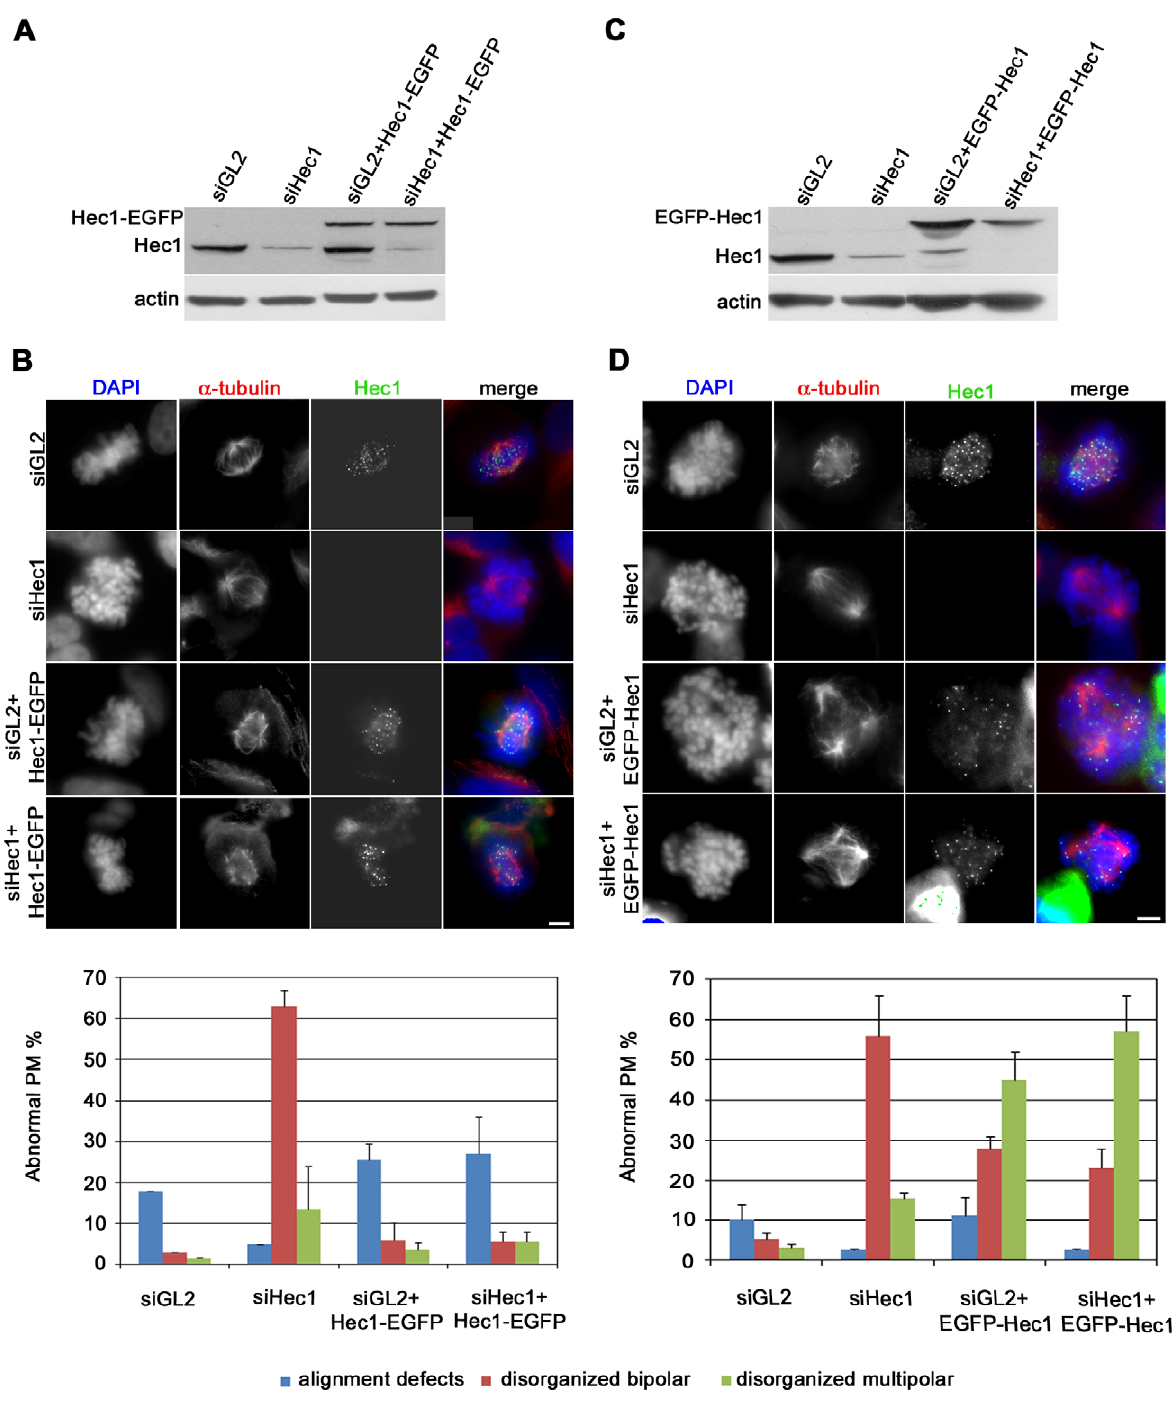
Figure 2. Expression of EGFP-Hec1 does not rescue the mitotic phenotypes induced by Hec1 depletion. (A) Western blot analysis of Hec1 depletion with or without induced Hec1-EGFP expression. (B) Chromosome congression and spindle organization after a -tubulin (red) and DAPI staining (blue) in control (siGL2) or Hec1 silenced (siHec1) mitoses or mitoses expressing Hec1-EGFP after control silencing (siGL2 + Hec1-EGFP) or after Hec1 silencing (siHec1 + Hec1-EGFP). In siGL2 and siHec1 samples, Hec1 is visualized by antibody staining. The graph reports the frequencies of prometaphase abnormalities in the different conditions in Hec1-EGFP cells. Data are mean 6 SE of 200 PM scored for each condition in two independent experiments. (C) Western blot analysis of Hec1 depletion with or without induced EGFP-Hec1 expression. (D) Chromosome congression and spindle organization after a -tubulin (red) and DAPI staining (blue) in control (GL2) or Hec1 silenced (siHec1) mitoses or mitoses expressing EGFP- Hec1 after control silencing (siGL2 + EGFP-Hec1) or after Hec1 silencing (siHec1 + EGFP-Hec1). In siGL2 and siHec1 samples, Hec1 is visualized by antibody staining. The graph reports the frequencies of prometaphase abnormalities in the different conditions in EGFP-Hec1 cells. Data are mean 6 SE of 200-300 PM for each condition in two-four experiments. Disorganized bipolar prometaphases were significantly induced by siHec1 in both clones (P , 0.01, t-test) and disorganized multipolar prometaphases were significantly induced after siHec1 in EGFP-Hec1 cells (P , 0.05, t-test).